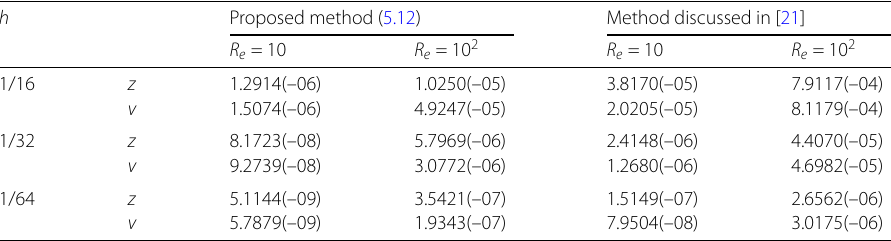
Table 5 Problem 8.5: The maximum absolute errors h Proposed method